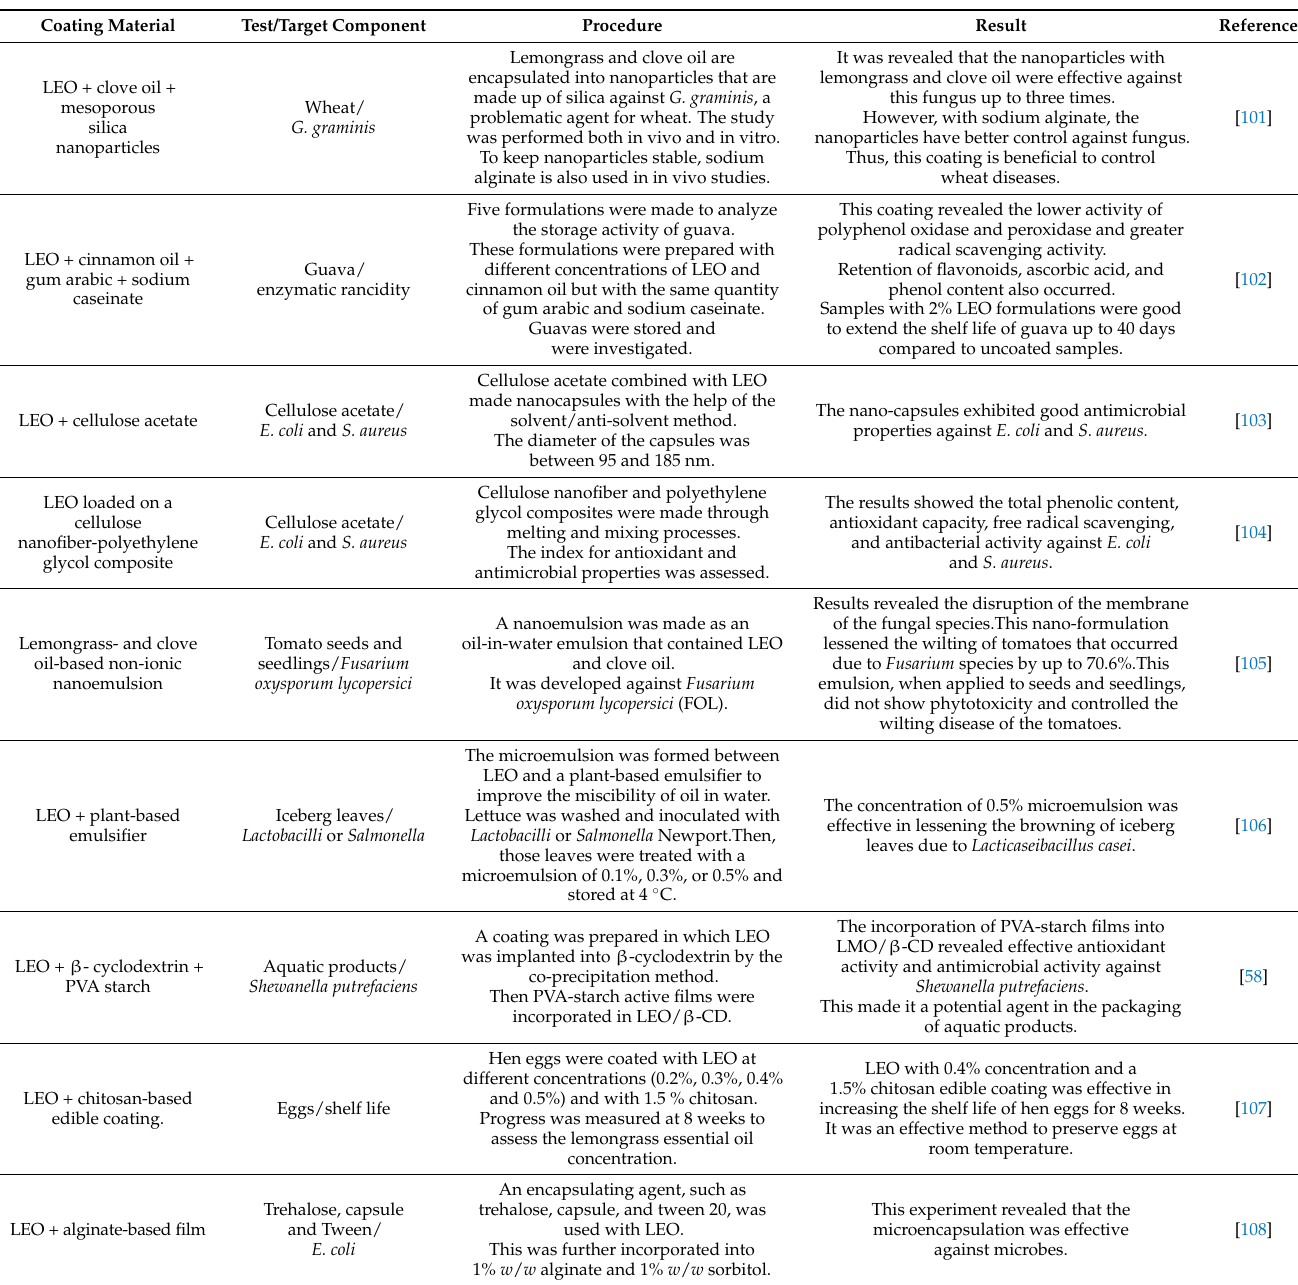
Table 2. Combination of LEO with different coating materials for food